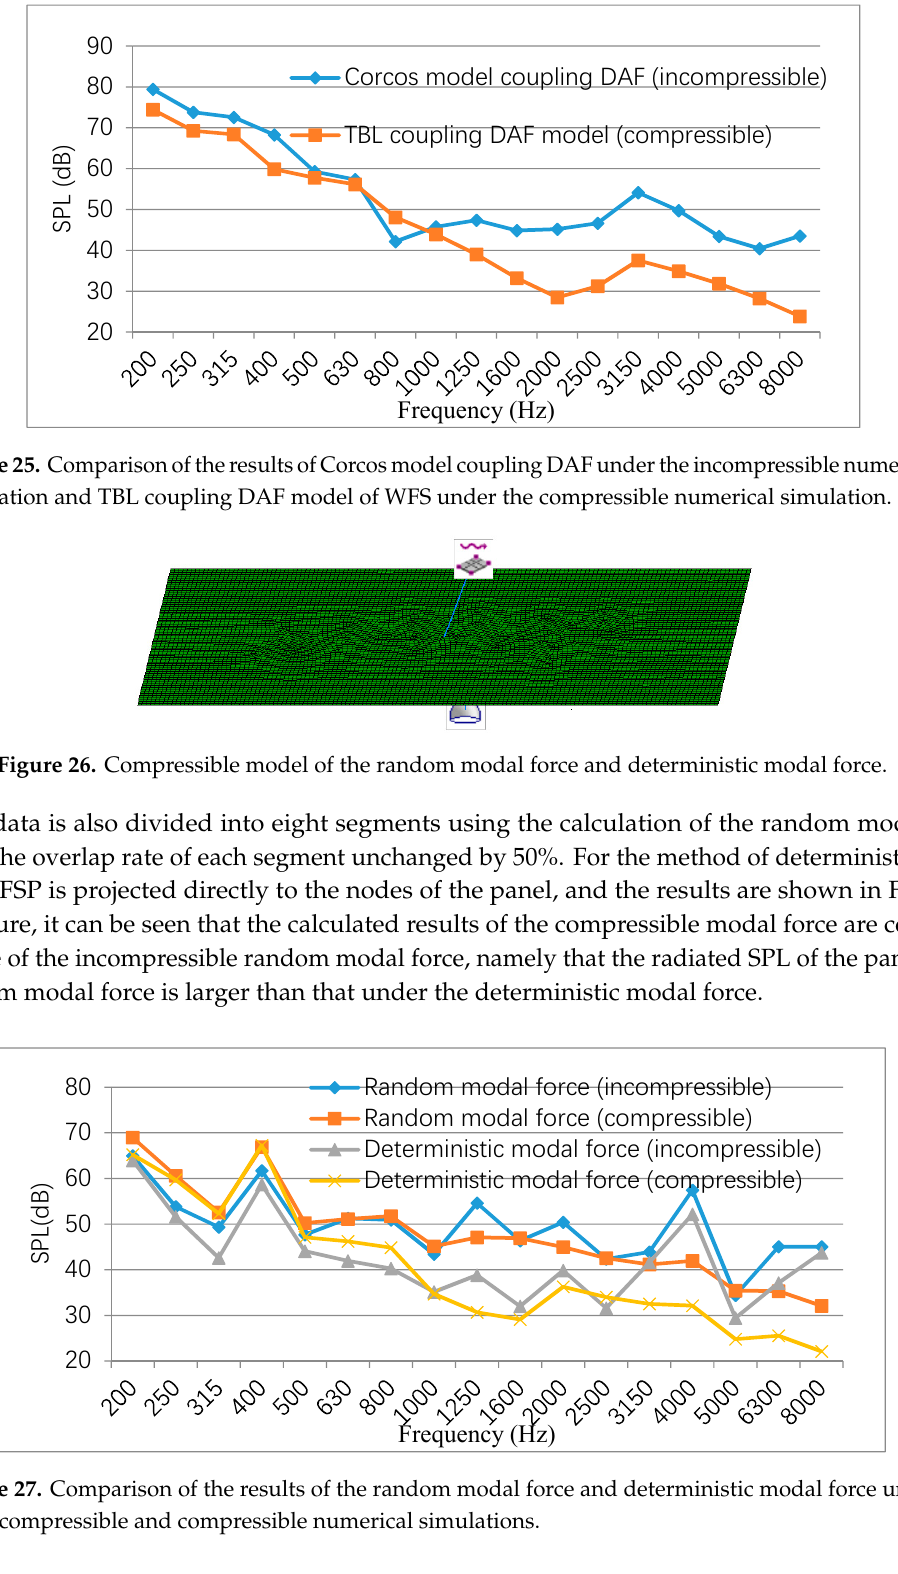
( b ) Figure 24. Wavenumber diagrams at different frequencies: ( a ) 1516 Hz; ( b ) 4042 Hz. 3.2.2. Aerodynamic Noise Analysis For the compressible numerical simulation of the FSP, the results of the WFS analysis show that the compressible numerical simulation of the FSP includes not only the convective component, but also the acoustic component. Therefore, for the compressible numerical simulation, the aerodynamic noise of the panel can be analyzed by using the convective and acoustic component obtained by the WFS analysis, random modal force and deterministic modal force. The convective and acoustic component obtained by the WFS analysis are represented by the TBL and DAF model. The TBL coupling DAF model of the WFS analysis is consistent with the model of Corcos model coupling BEM method of the incompressible numerical simulation. Figure 25 shows the results of the radiated SPL of the compressible numerical simulation comparing that of the incompressible numerical simulation. We can see that there is a peak value of the radiated SPL of the panel in the compressible numerical calculation at 3150 Hz , which is consistent with the results of the incompressible numerical simulation. However, the results of the compressible numerical